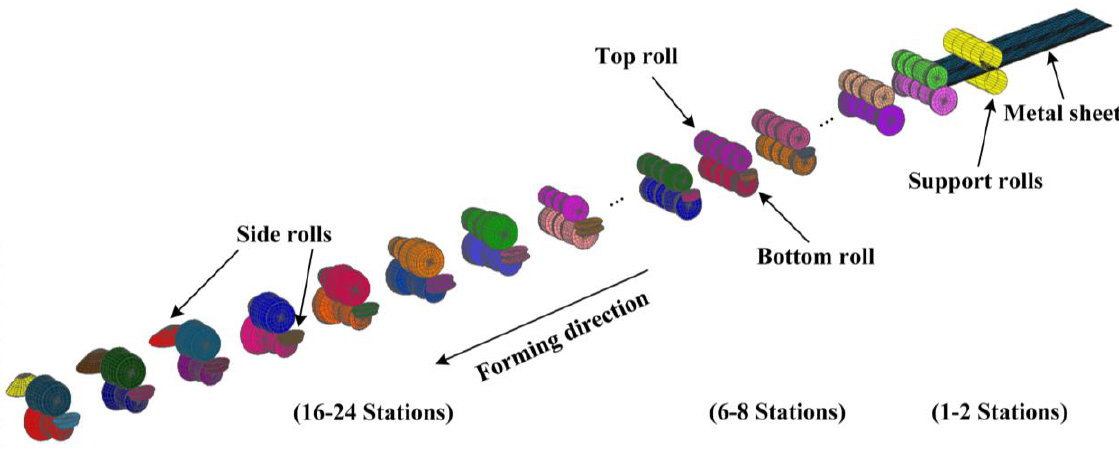
Figure 1. Assembly of cold roll forming.